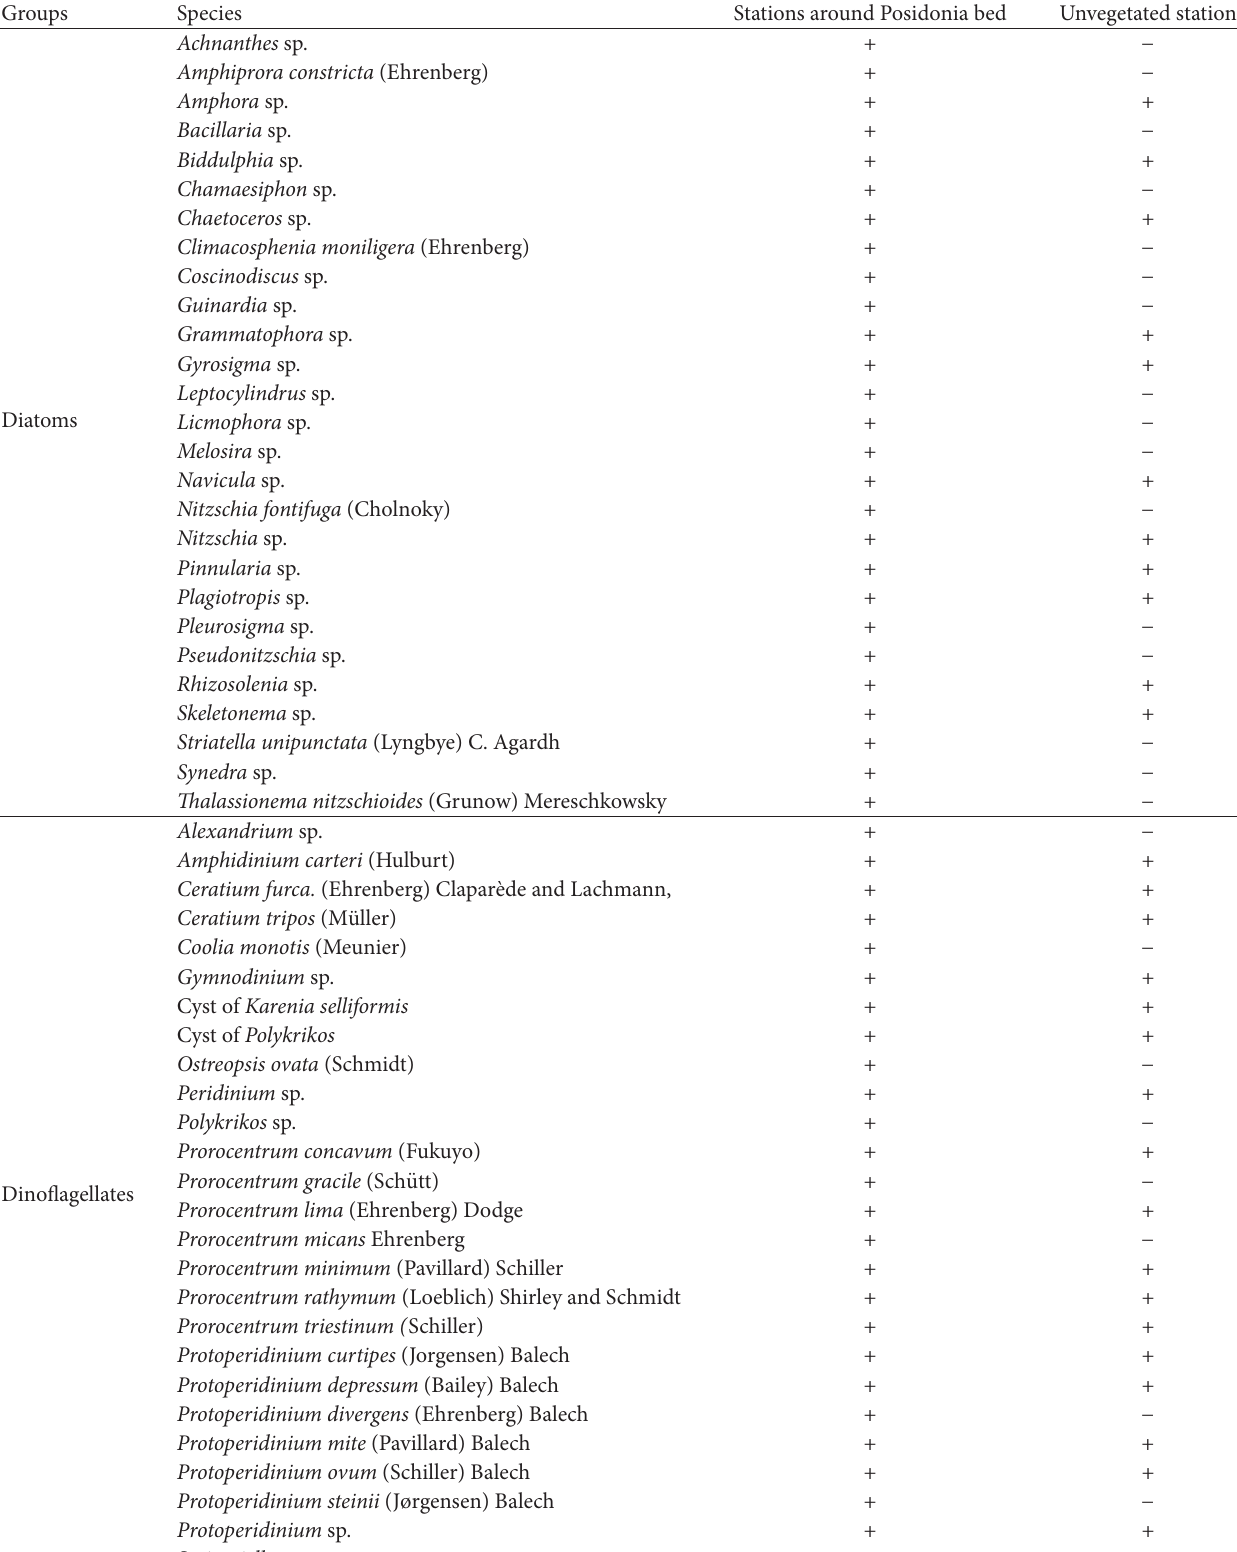
Table 4: Species list of microalgae and cyanobacteria identified on water column around P. oceanica bed and in unvegetated station.